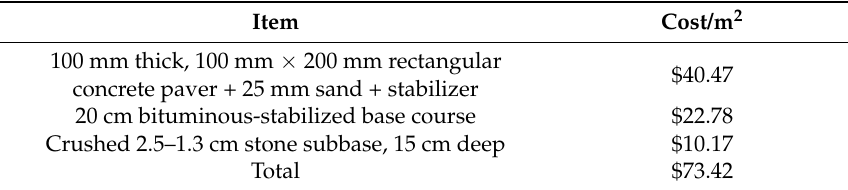
Table 3. Primary yard cost components total cost value (2012 US dollars) [42,43].